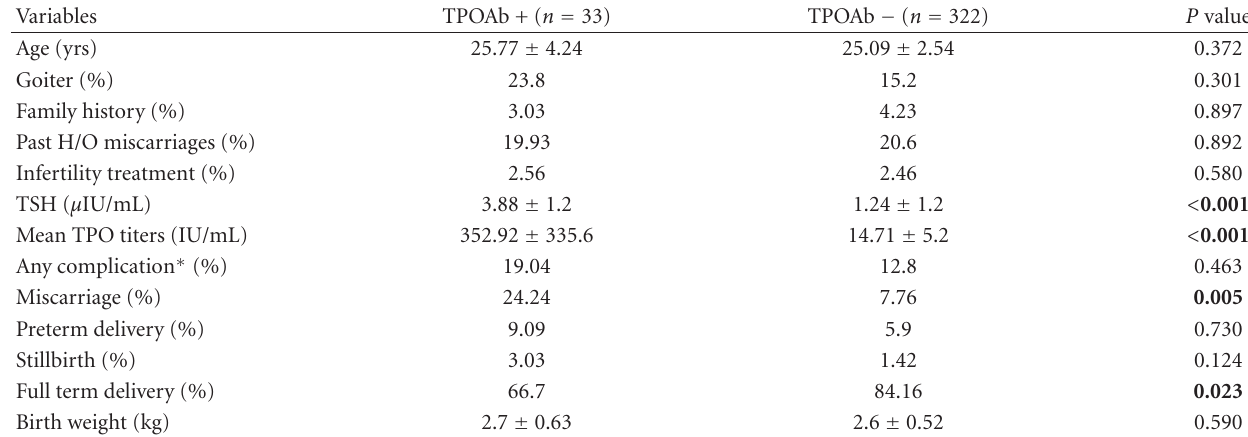
Table 3: Comparison between TPOAb-positive and -negative women #